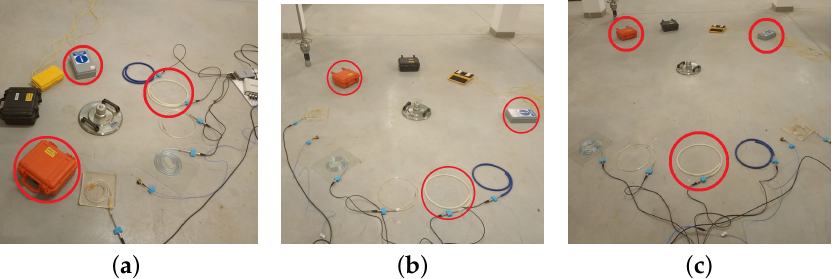
Figure 6. Comparative experiment (the alternative types of the sensors being developed presented in this paper are marked in red): ( a ) a distance of 0.5 m from the calibrated stroke; ( b ) a distance of